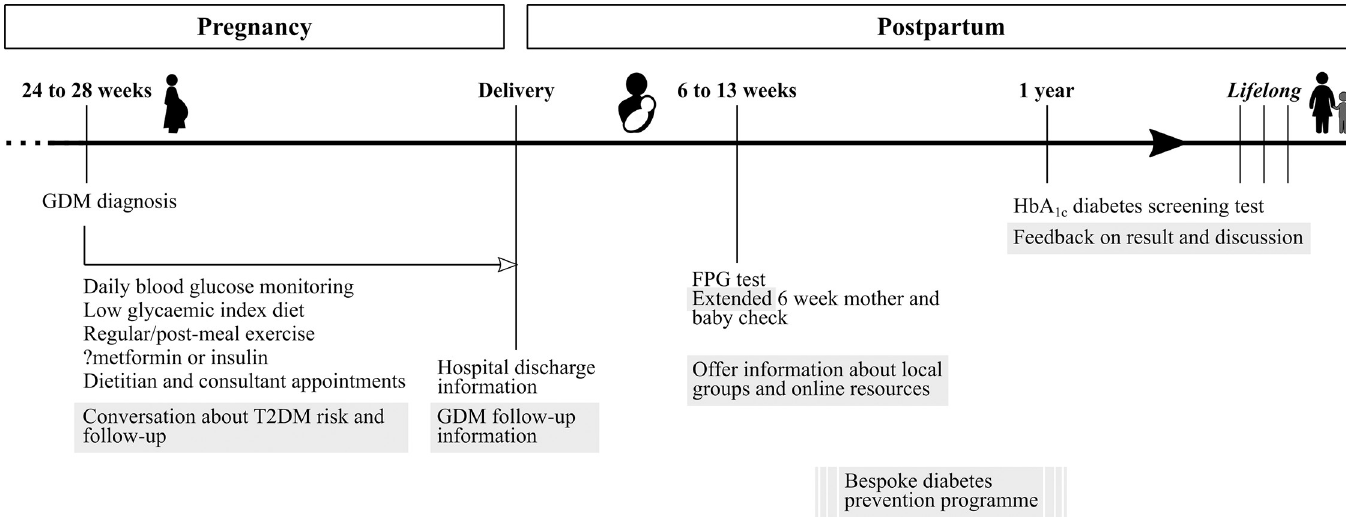
Fig 2. Summary of key proposed amendments to current GDM pregnancy and postpartum care. Proposed amendments are shaded in grey. Abbreviations: FPG– fasting plasma glucose test; HbA 1c –glycated haemoglobin test.